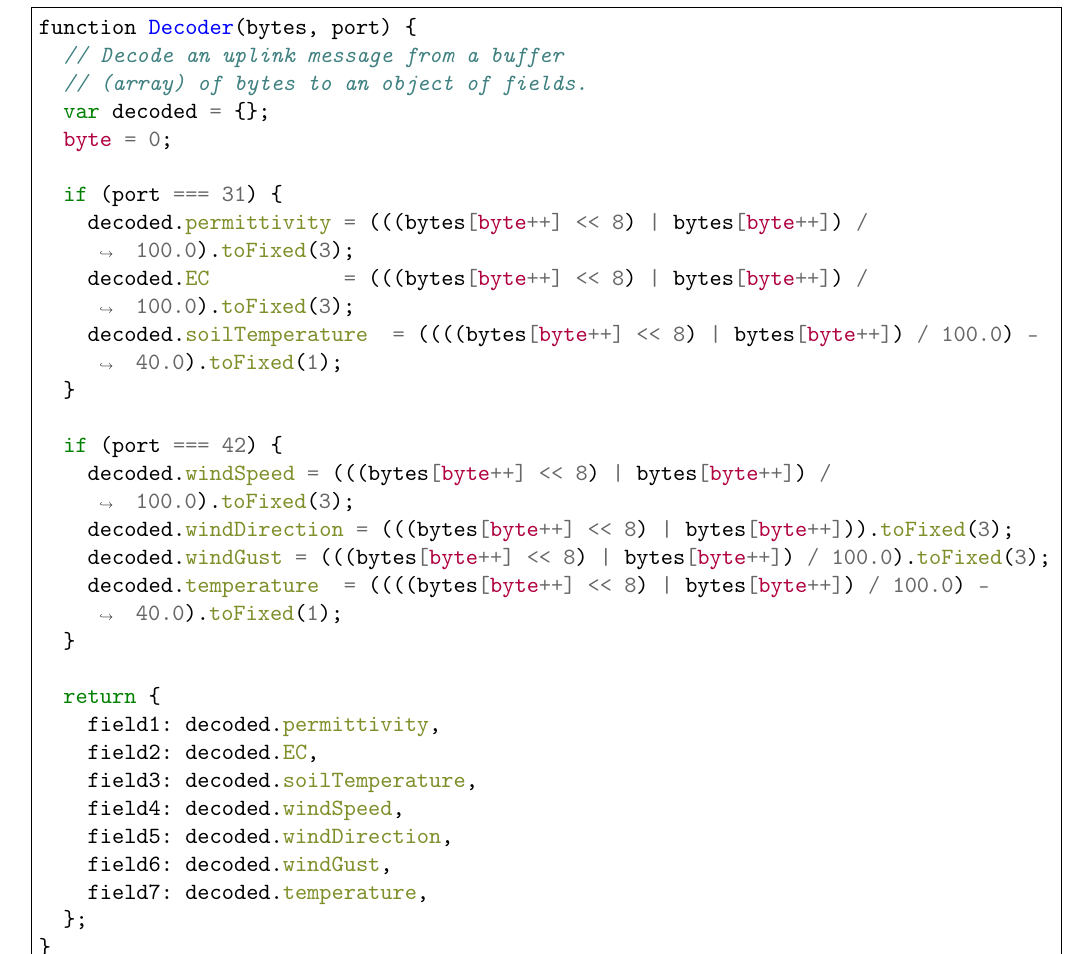
Figure 8. Example of one decode function at TheThingsNetwork (TTN) to obtain data from